Question: Sum up the contents of this chart in one sentence.
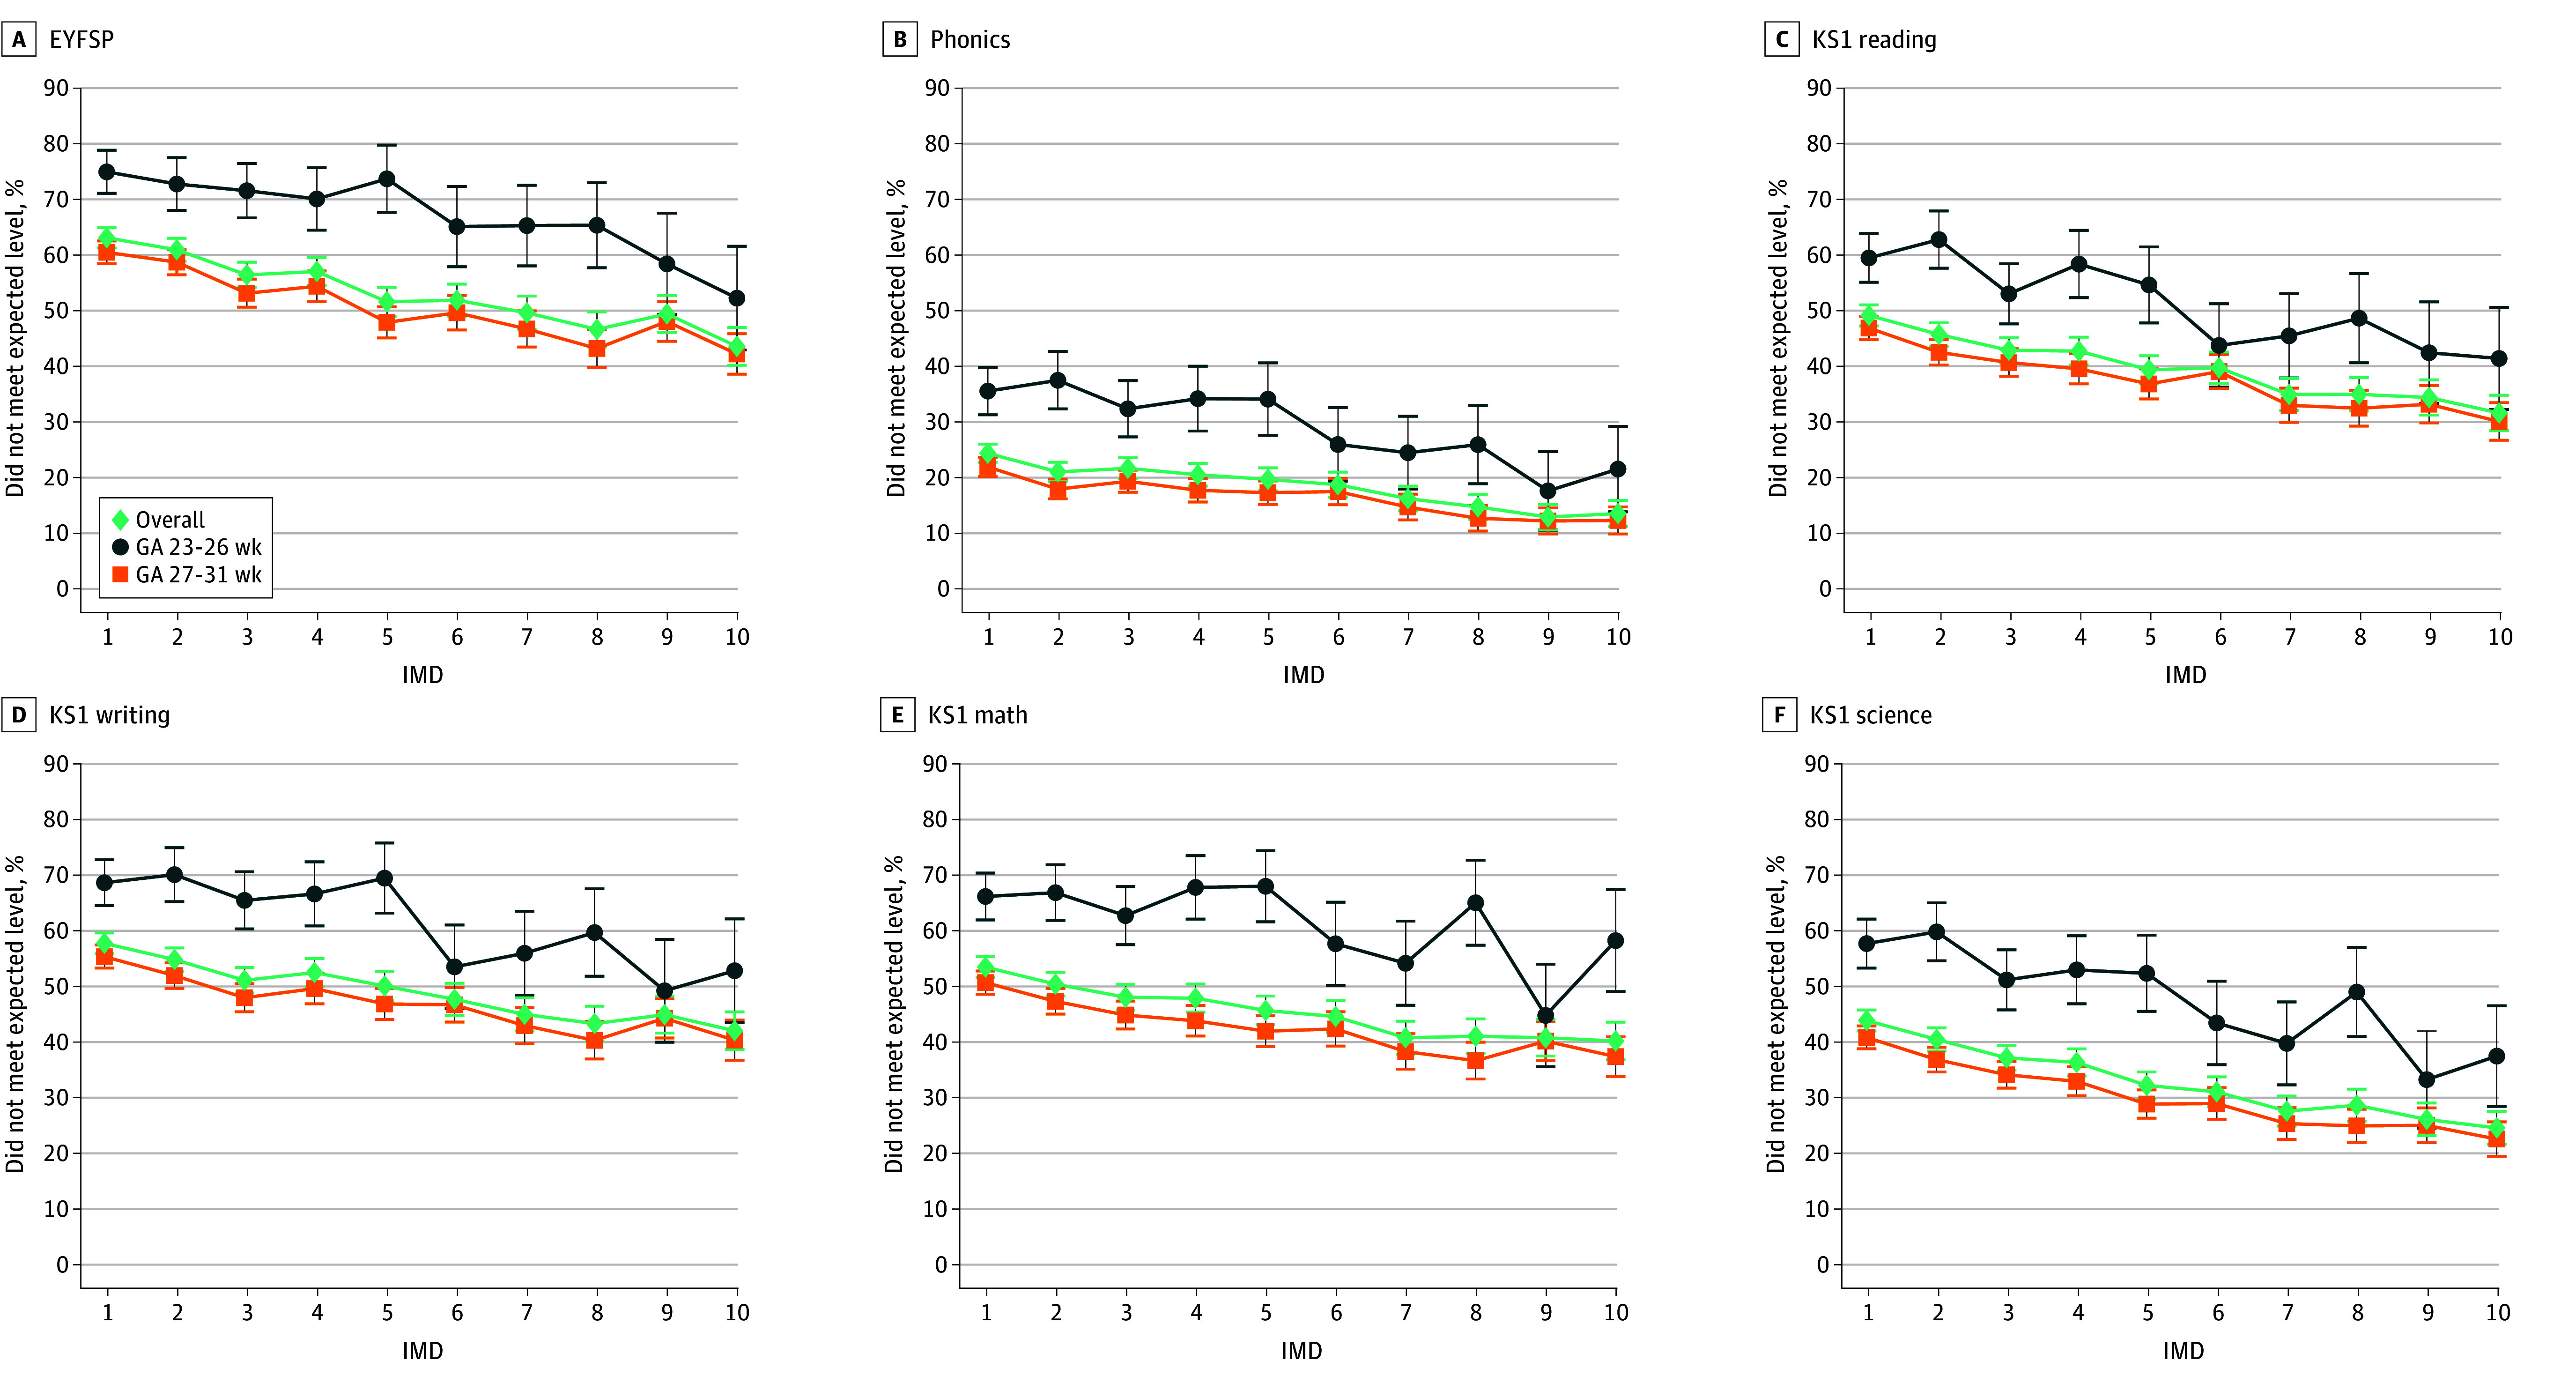
Answer: Dot Plots of the Proportion of Children Who Did Not Meet the Expected Level in Outcomes by Socioeconomic Status at Birth (Index of Multiple Deprivation [IMD]), Stratified by Gestational Age (GA) Category and the Overall Cohort Trend tested using the Cochran-Armitage test. P < .001 for every line. Error bars indicate the 95% CI. Index of Multiple Deprivation decile 1 indicates the most deprivation and decile 10, the least deprivation. EYFSP indicates Early Years Foundation Stage Profile; KS1, key stage 1.